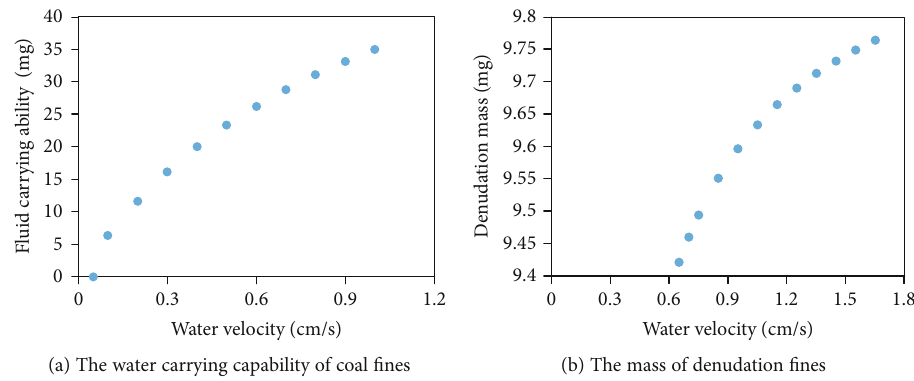
Figure 5: The assumptions on calculation parameters.